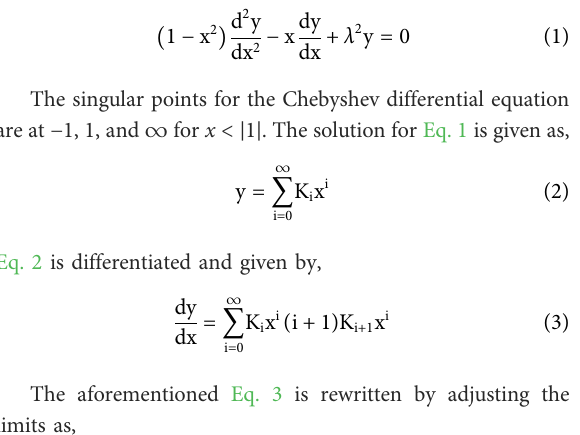
FIGURE 3 Proposed triple-times voltage-boosting inverter topology